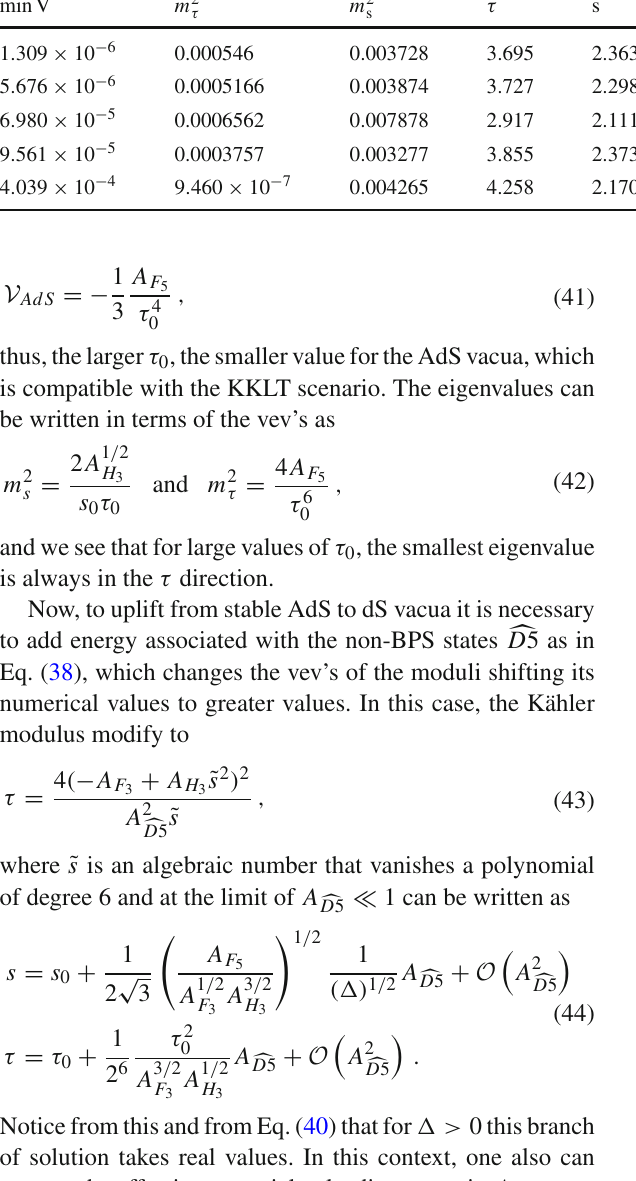
Table 1 Selected vacua found by the hybrid SA+CG algorithm minV m 2